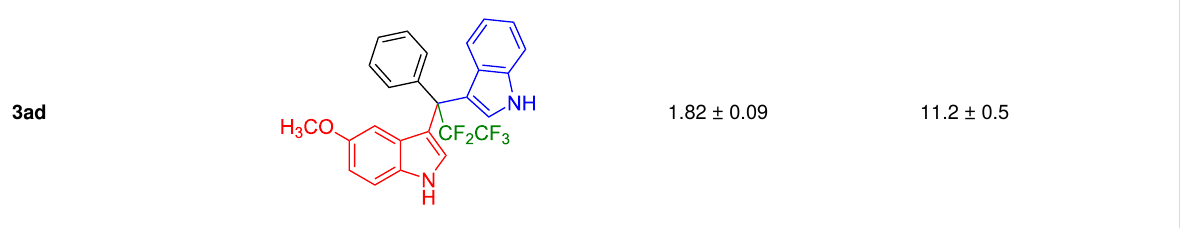
present series with a K i value of 1.82 µM. The binding curves of 3e and 3ad are depicted in Supporting Information File 1, Figure